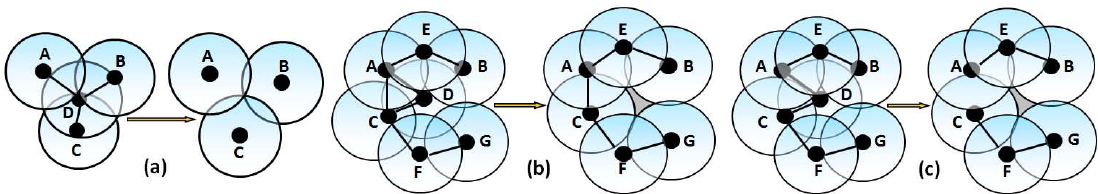
Figure 1. Example of the consequences of coverage holes. ( a ) Loss of connectivity due to death of node D ; ( b ) Coverage hole due to death of node D ; ( c ) Both coverage and connectivity hole due to death of node D